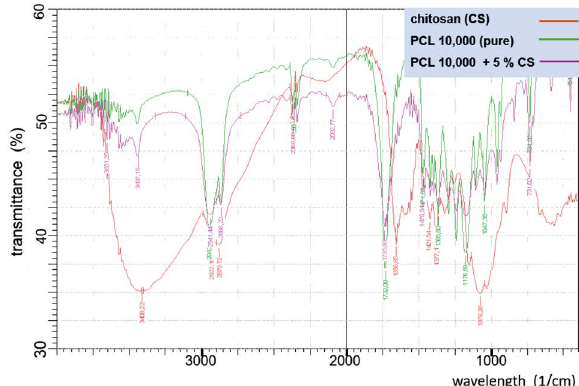
Figure 2. The FTIR spectra of raw materials (PCL (M w = 10,000 g/ mol) and CS) and the composite material.